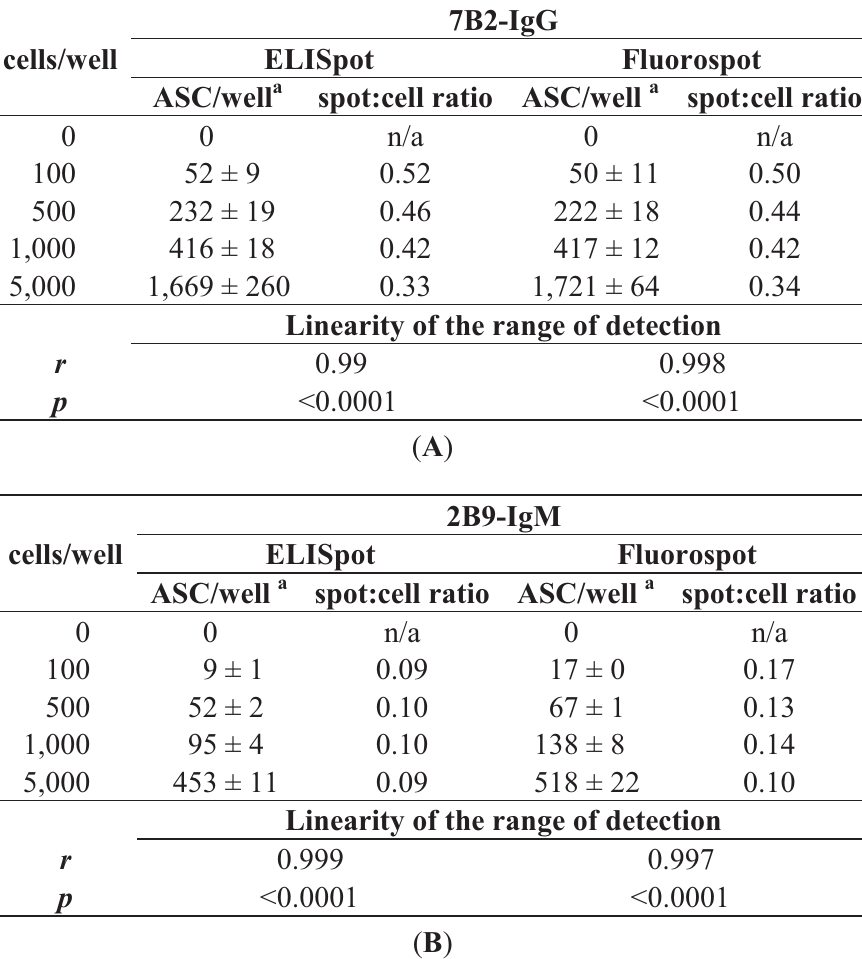
Table 1. Linearity of detection and comparison between numbers of ( A ) IgG and ( B ) IgM ASCs/well obtained with the traditional ELISpot and the novel B cell fluorospot